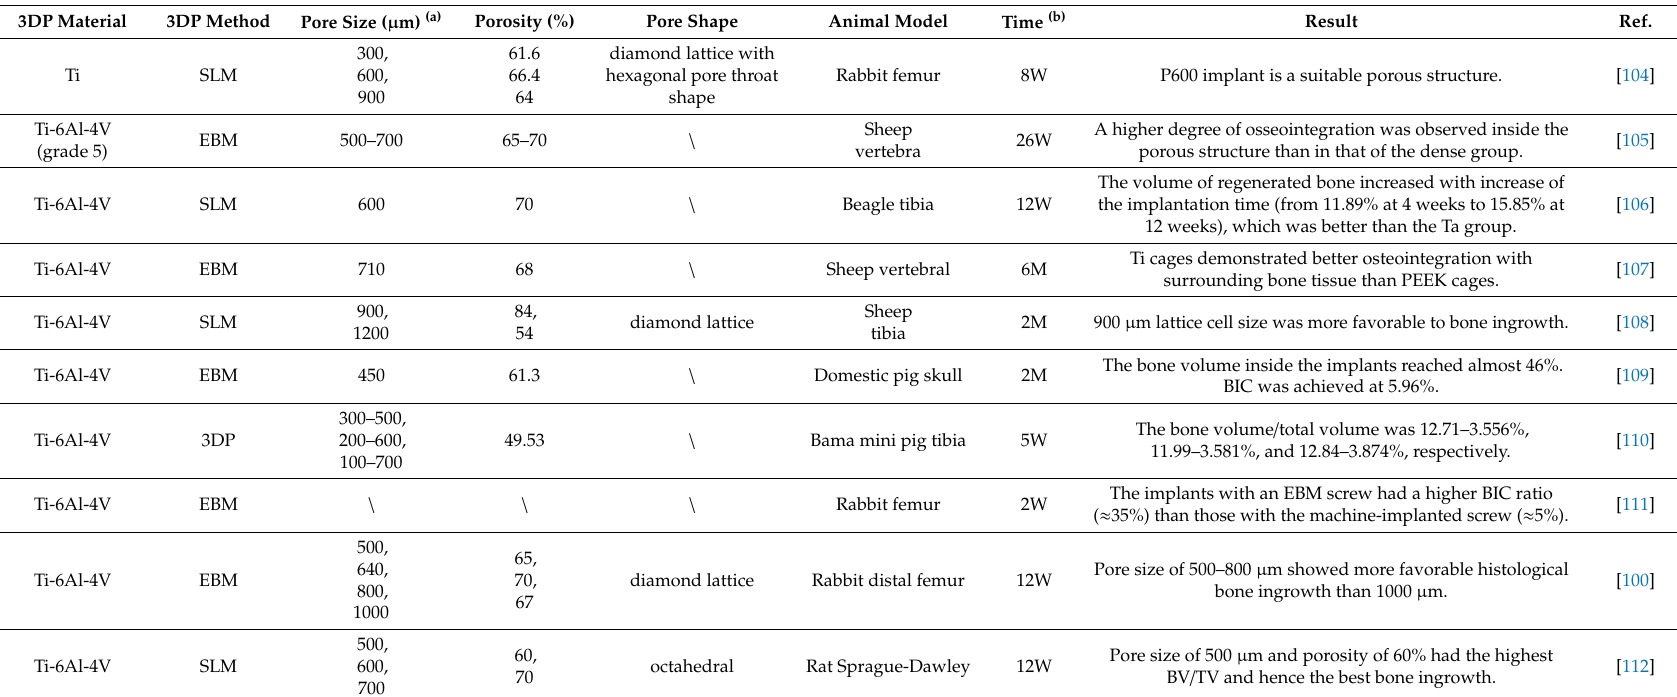
Table 1. The important parameters for 3DP architectured implant preparation, in vivo